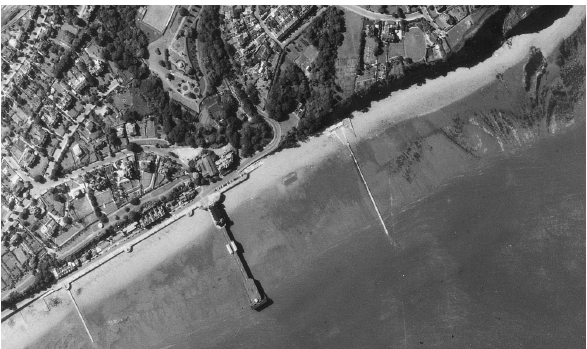
Figure 4 – Vertical Aerial Photograph of Penarth